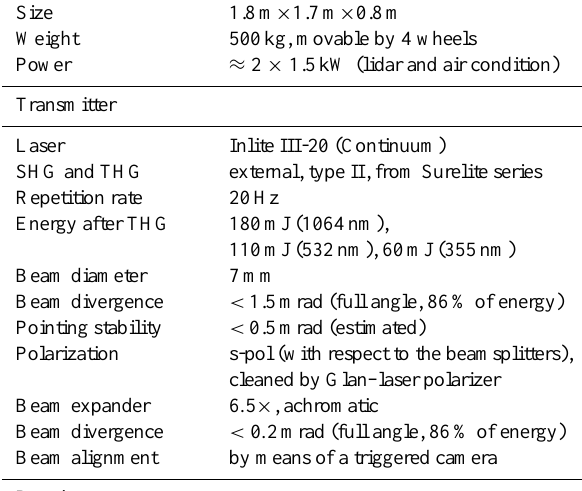
Table 2. Specification of the portable Raman lidar Polly XT (gener- ation 3). N/R denotes the near-range receiver